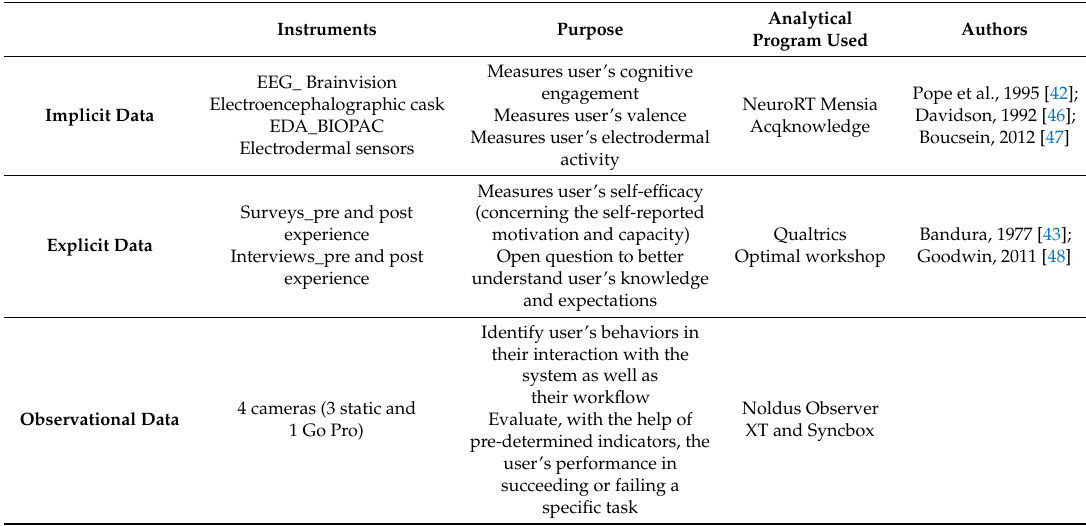
Table 3. Summary of the data collection and analysis